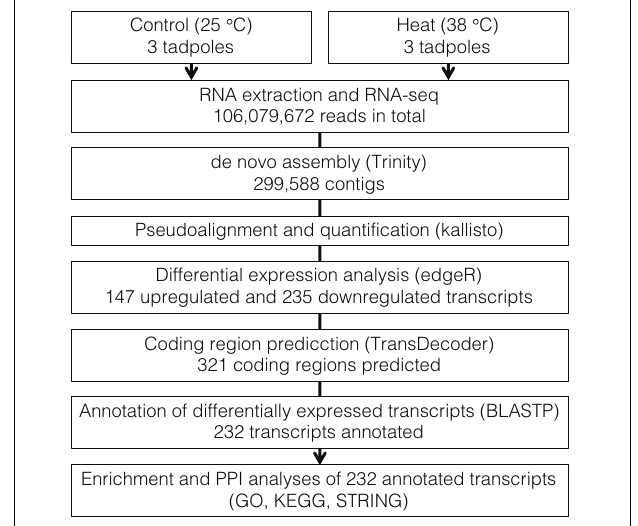
FIGURE 1 | Flowchart of the current